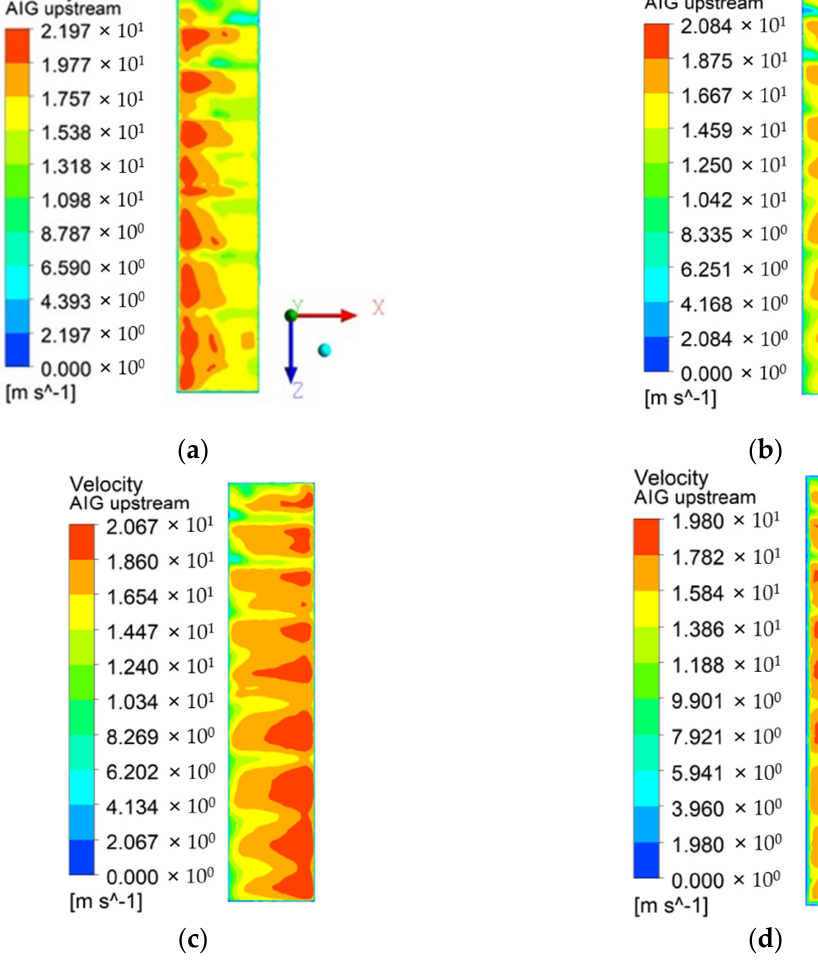
Figure 5. Contours of the velocity field distribution upstream of the AIG corresponding to the different schemes: ( a ) Scheme 1; ( b ) Scheme 2; ( c ) Scheme 3; ( d ) Scheme 4. Table 2. Summary of C V values of the velocity field distribution upstream of the AIG corresponding to different schemes.